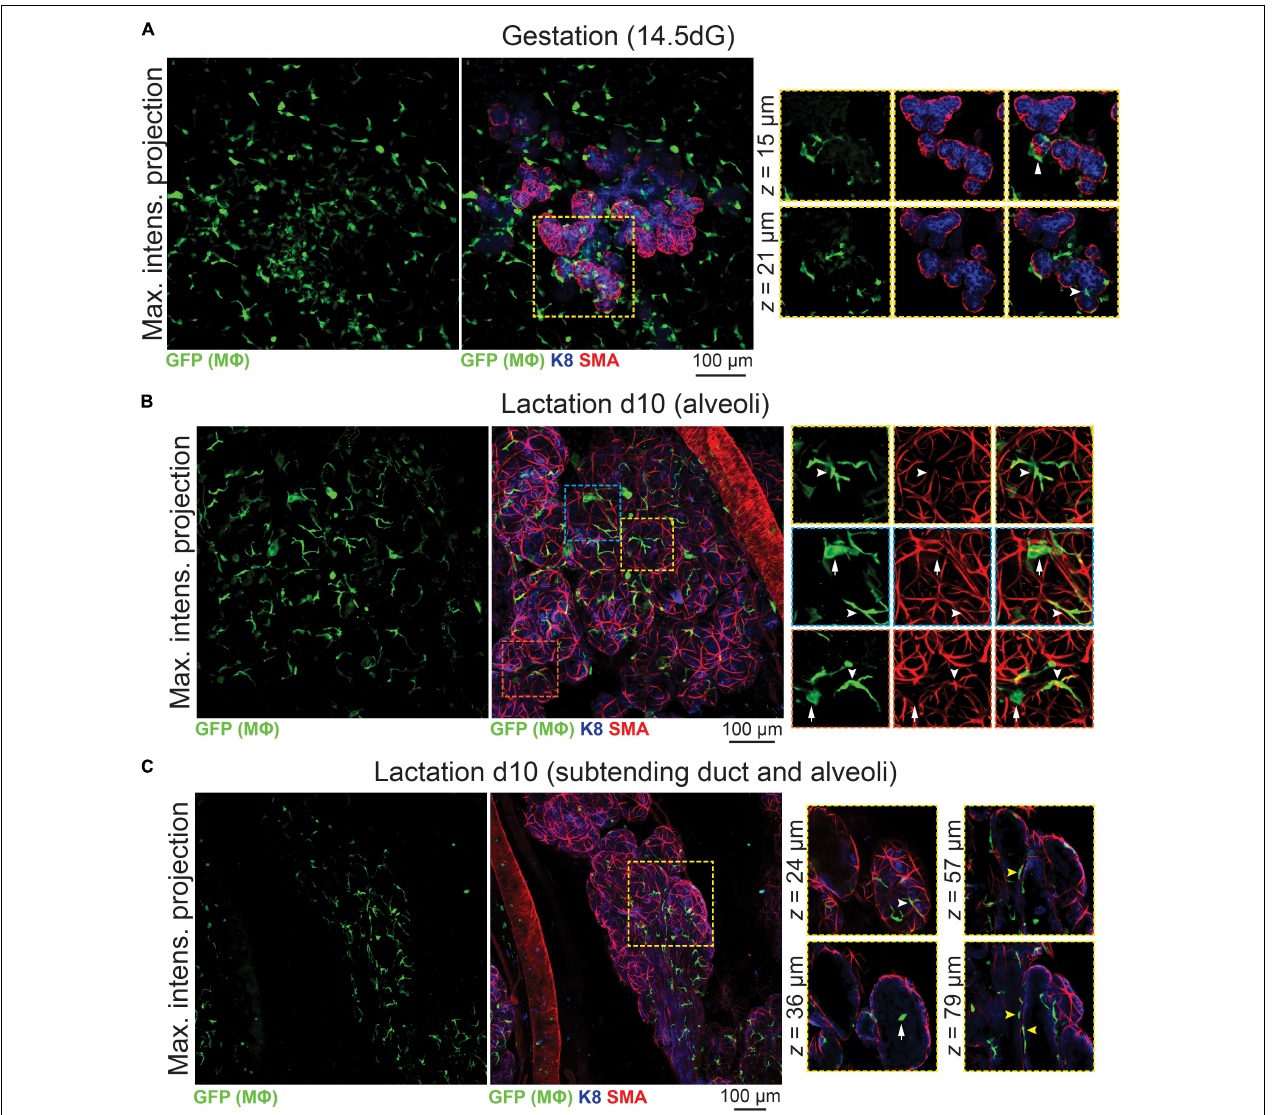
FIGURE 4 | M φ s in the mammary glands of pregnant and lactating mice. Maximum intensity z -projection and single optical ( z ) slices of cleared mammary tissue from (A) pregnant (14.5 days gestation, dG) and (B,C) lactating (day 10 lactation, d10) Csf1r-EGFP mice. K8 immunostaining reveals K8-positive luminal cells; smooth muscle actin (SMA) marks the basal/myoepithelial cells and SMA-positive vessels. Arrowheads in (A) show M φ s that are interacting with the developing alveolar epithelium. In (B,C) , white arrowheads show M φ s that are aligned along basal cells (versus white arrows showing M φ s that are not imitating basal cell morphology). Yellow arrowheads in (C) show M φ s that are positioned between the ductal epithelial bilayer. Images are representative of 3 mice at each developmental stage.